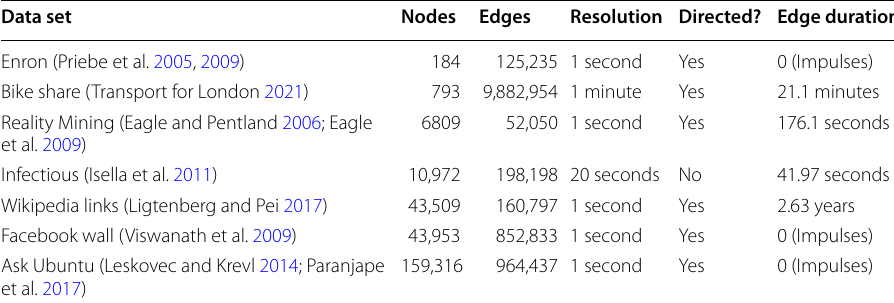
Table 2 Data sets used for evaluation